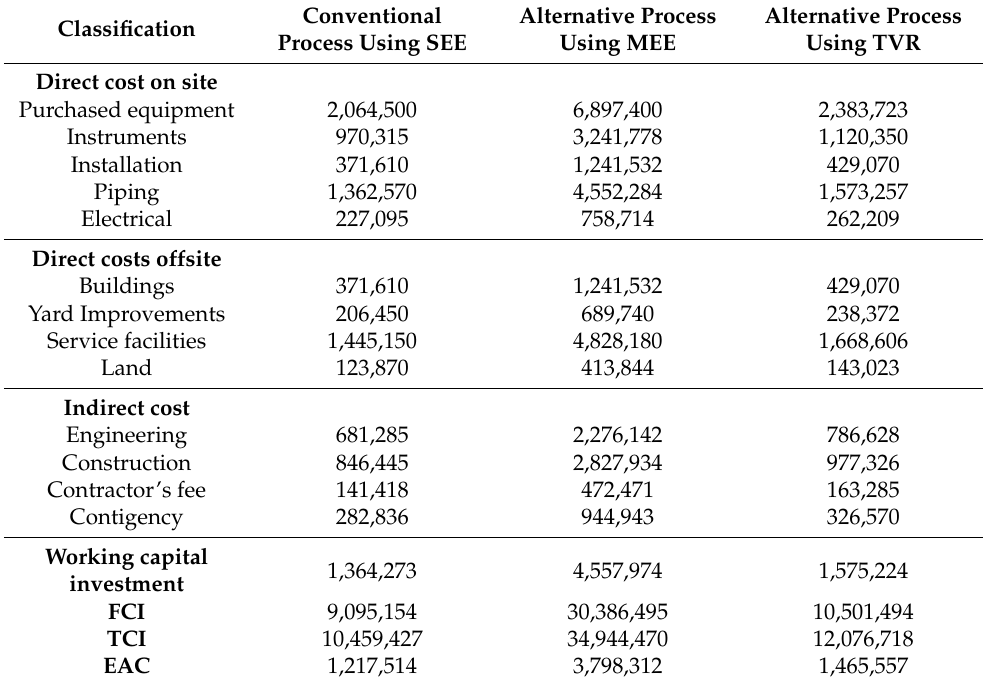
Table 7. EAC of each